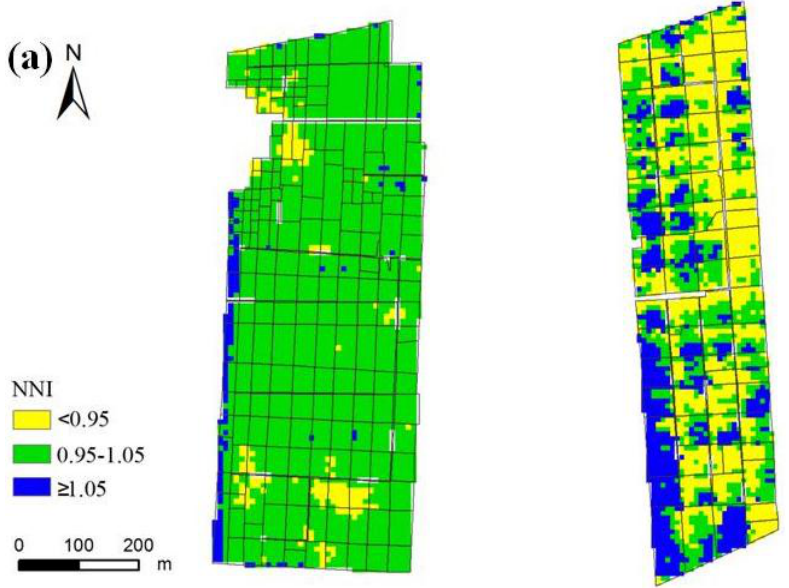
Figure 2. Relationship between observed and predicted NNI using MCARI-estimated biomass and RVI3-estimated plant N uptake in 2011 and 2012, Heilongjiang Province, China. The red line is the 1:1